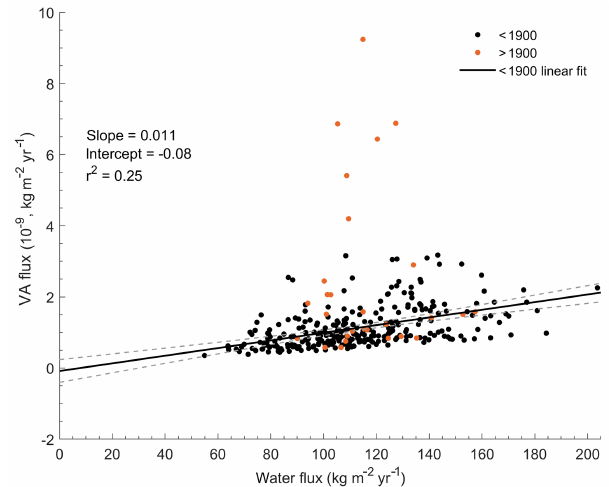
Figure 7. Relationship between Tunu vanillic acid depositional flux and water accumulation flux with linear regression to samples with ages older than 1900CE (black points and line). Data younger than 1900 are shown in orange. Gray dashed lines show the uncertainty in the slope and intercept. Data below the limit of detection are not